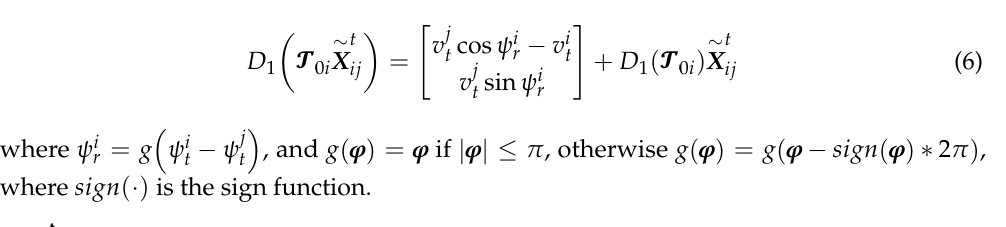
Figure 1. Coordinate